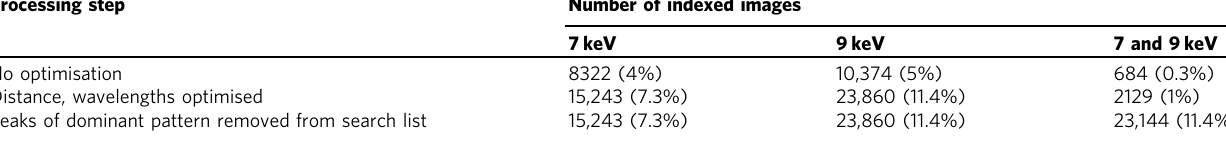
Table 1 Indexing rate of the 208,373 hits at the various stages of the analysis Processing step